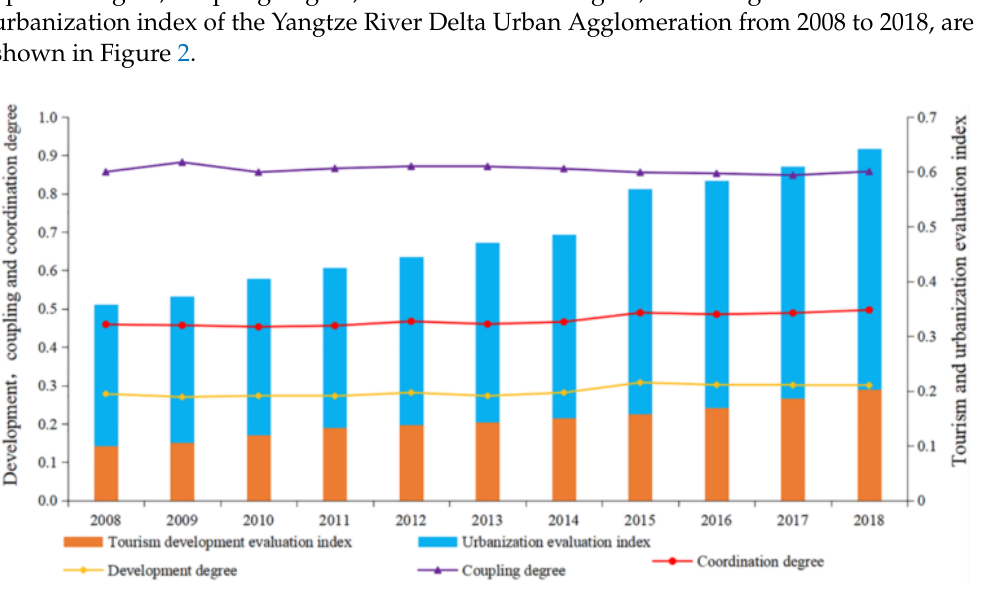
Figure 2. Trends of evaluation index and development, coupling, and coordination degrees of tourism and urbanization.